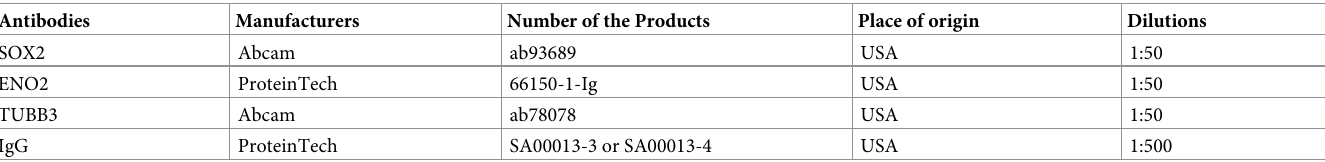
Table 4. Details of antibodies against the proteins in